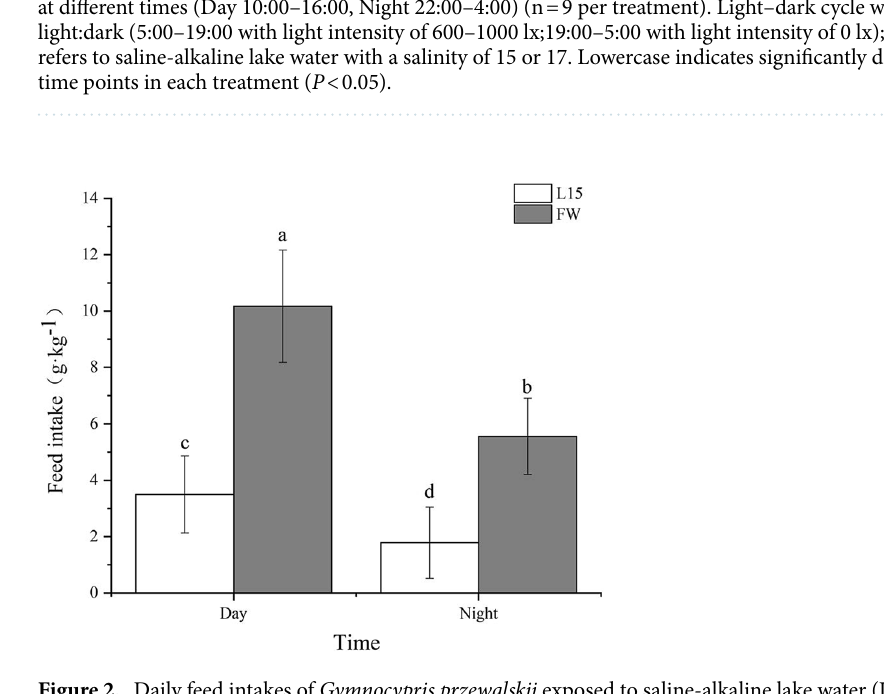
Figure 2. Daily feed intakes of Gymnocypris przewalskii exposed to saline-alkaline lake water (L15) and fresh water (FW) at different times (Day 5:00–19:00, Night 19:00–5:00) (n = 3 per treatment). Light–dark cycle was 14:10-h light:dark (5:00–19:00 with light intensity of 600–1000 lx;19:00–5:00 with light intensity of 0 lx); L15 refers to saline-alkaline lake water with a salinity of 15; Lowercase indicates significantly difference between phases in each treatment ( P <